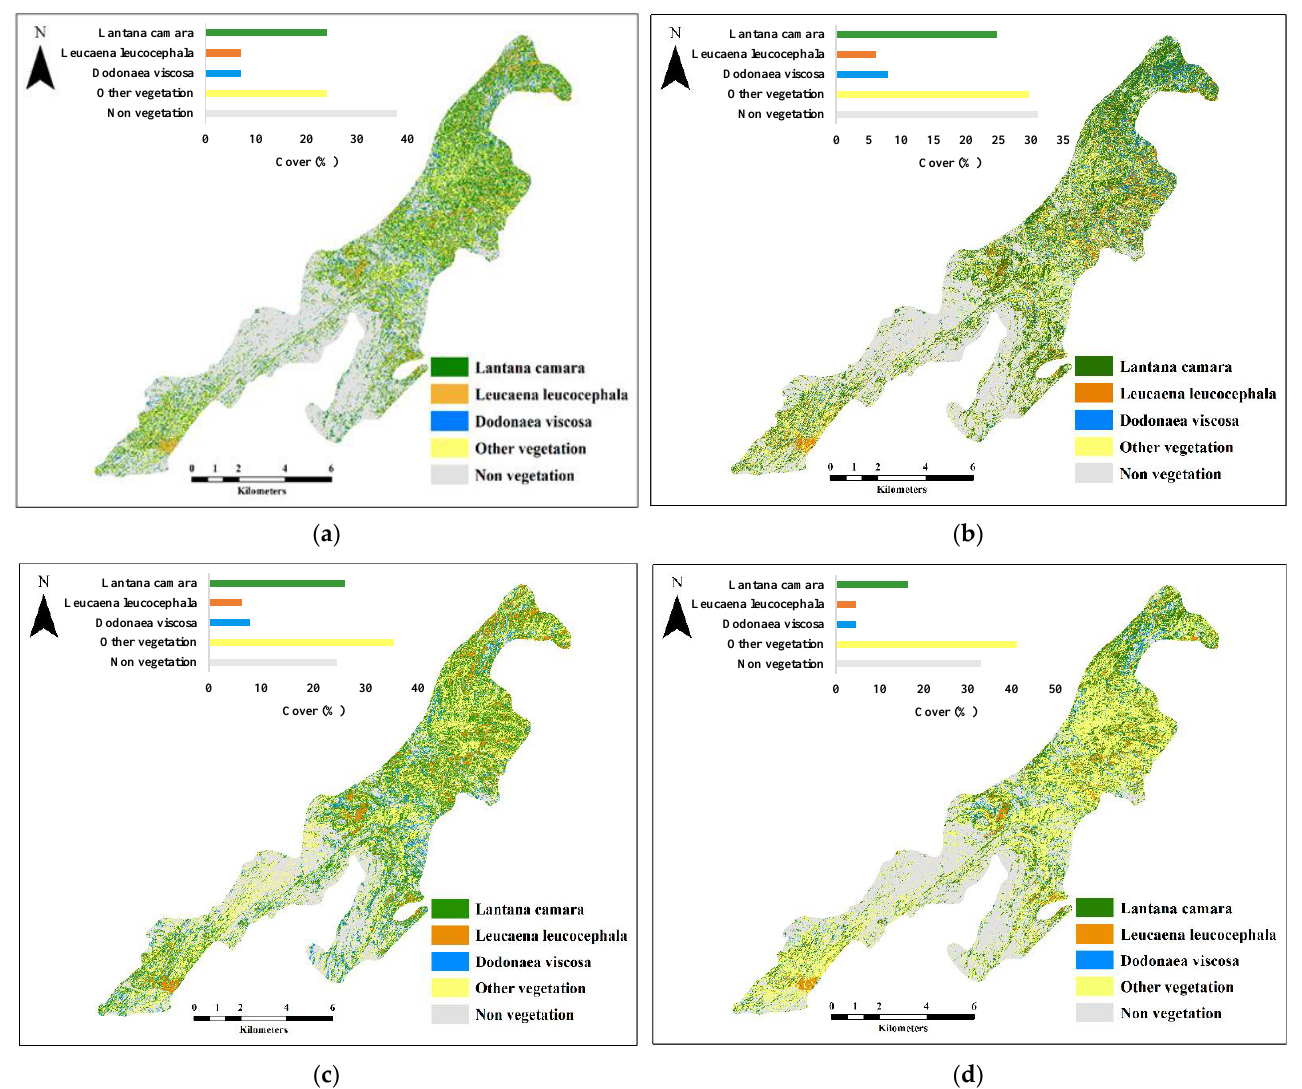
Figure 4. Distribution cover map of five classes in Lehri – Jindi Reserve Forest generated through different classification approaches using PlanetScope data. Random forest, ( a ) Gaussian mixture model, ( b ) k-nearest neighbour, ( c ) support vector machine ( d ).